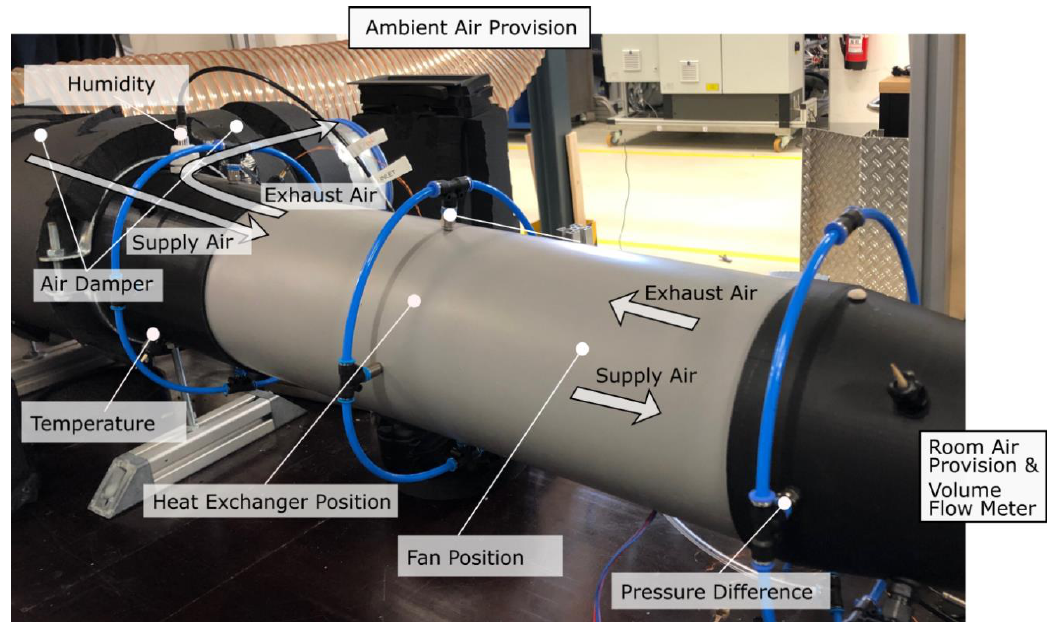
(Figure 3: Ambient Air Provision). The ambient air had a temperature of approximately 8 relative humidity of 37%. These conditions on both sides of the device were constantly measured.